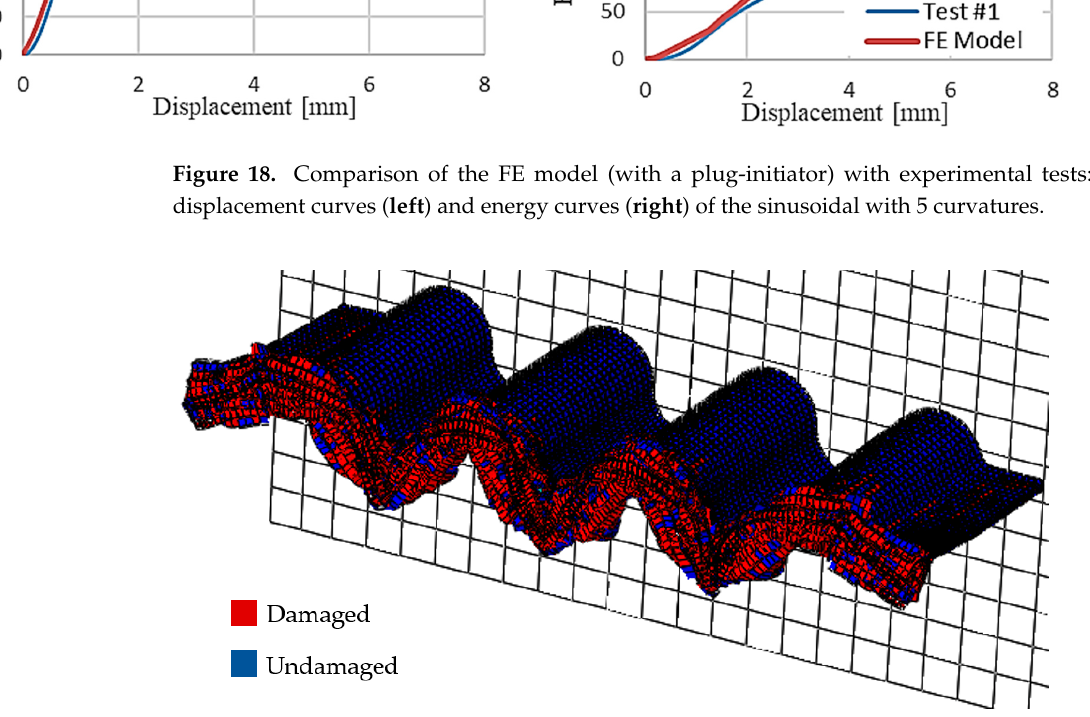
Figure 19. Simulated deformed shapes of the sinusoidal specimen with 7 curvatures.